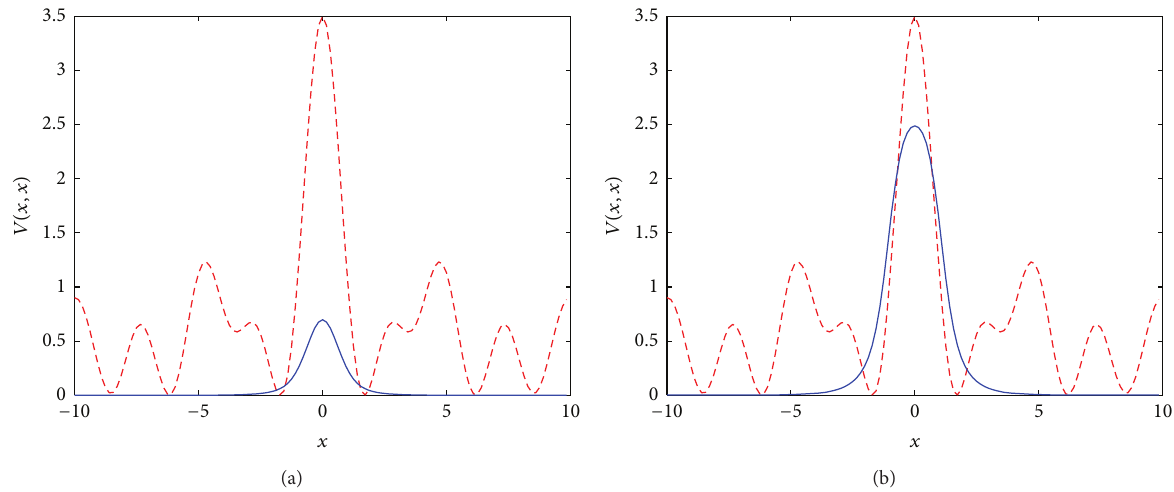
Figure 8: The lattice soliton profiles for the self-focusing cubic and the self-defocusing quintic model. (a) Cross section along 𝑥 -axis of the lattice solitons corresponding to the first renormalization factor (solid line) superimposed on the underlying Penrose potential (dashed line). (b) Cross section along 𝑥 -axis of the lattice solitons corresponding to the second renormalization factor (solid line) superimposed on the underlying Penrose potential (dashed line).